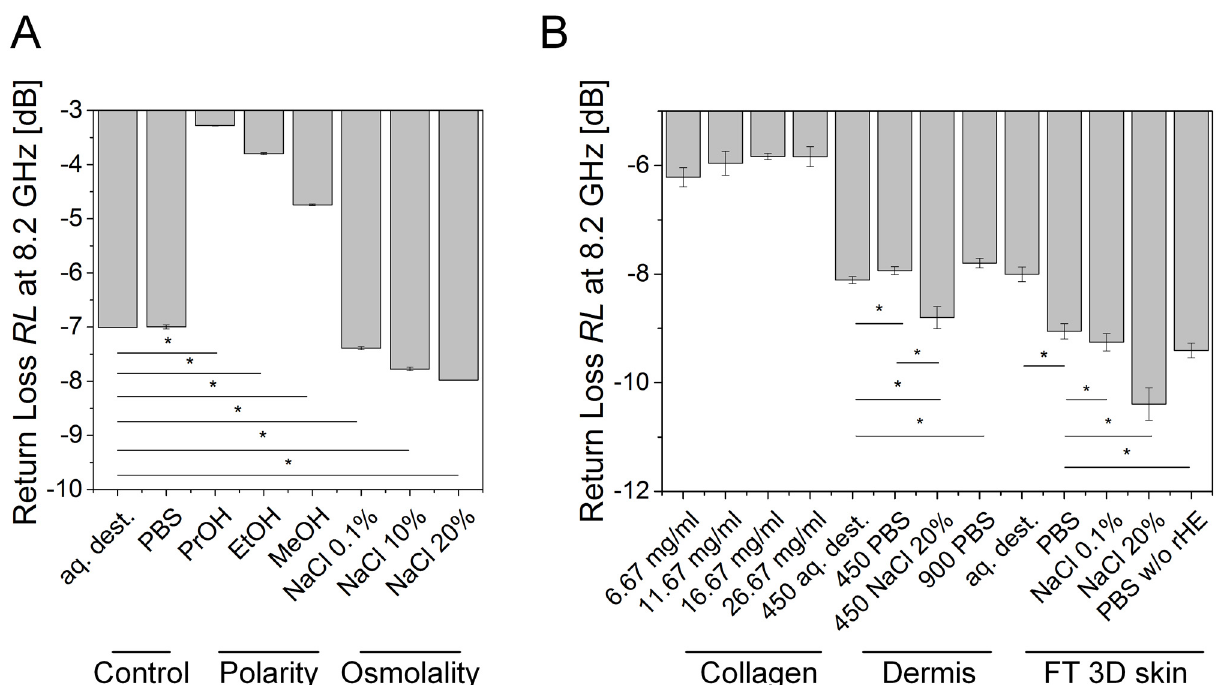
Fig 6. Microwave signal of fluids and in vitro test models measurements at 8.2 GHz. (A) Microwave measurements with fluids. Compared to Control, RL showed increased values for polarity measurements (Polarity) at a constant frequency of 8.2 GHz with a lower polarity from aq. dest. to PrOH. Osmolality measurements displayed a decreasing RL with the highest osmolality at NaCl 20%. (B) Microwave measurements with in vitro models. RL displayed increasing values at a constant frequency of 8.2 GHz for measurements with cell-free collagen hydrogels (Collagen). RL dropped with higher osmolalities for both dermal (Dermis) and full-thickness 3D skin models (FT 3D skin). Bar diagrams depict mean values, error bars depict standard deviations. Asterisks indicate statistical relevant differences ( p -value (cid:2) 0.5). Each group comprised 3 individual samples that were measured in triplicate.